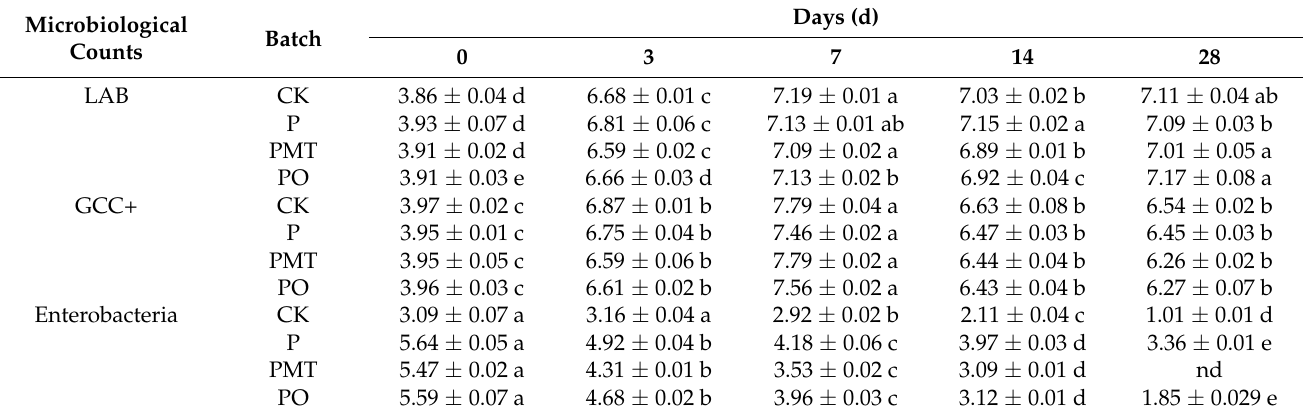
Table 3. Microbial counts (log 10 CFU g-1) during ripening of smoked horsemeat